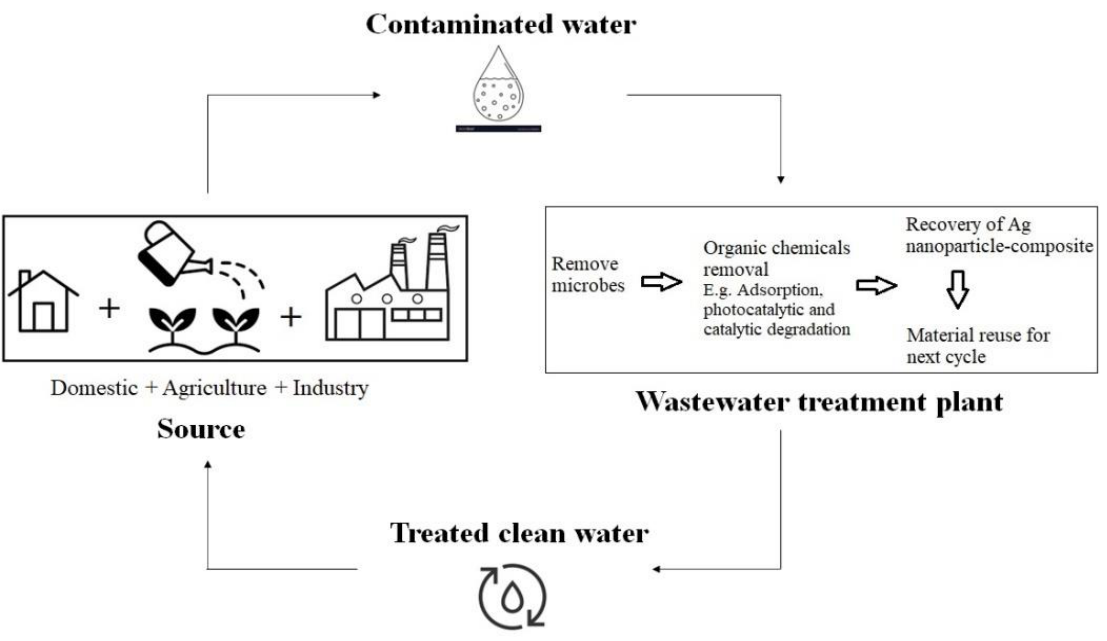
Figure 4. Flowchart for the silver nanoparticle compound for wastewater treatment (adapted from